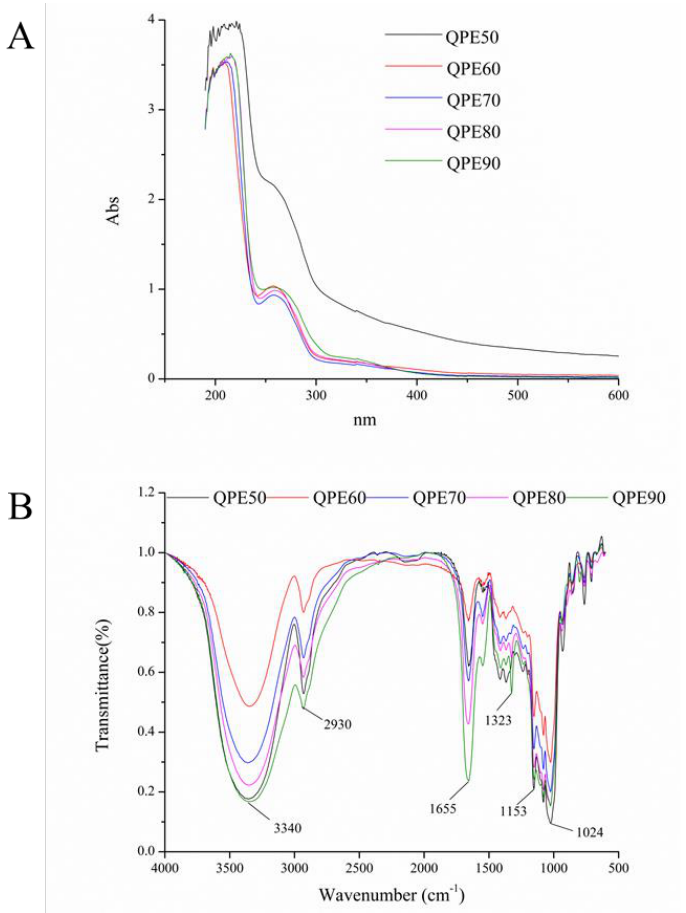
Figure 3. Ultraviolet spectrum ( A ) and FT-IR spectrum ( B ) of QPs.